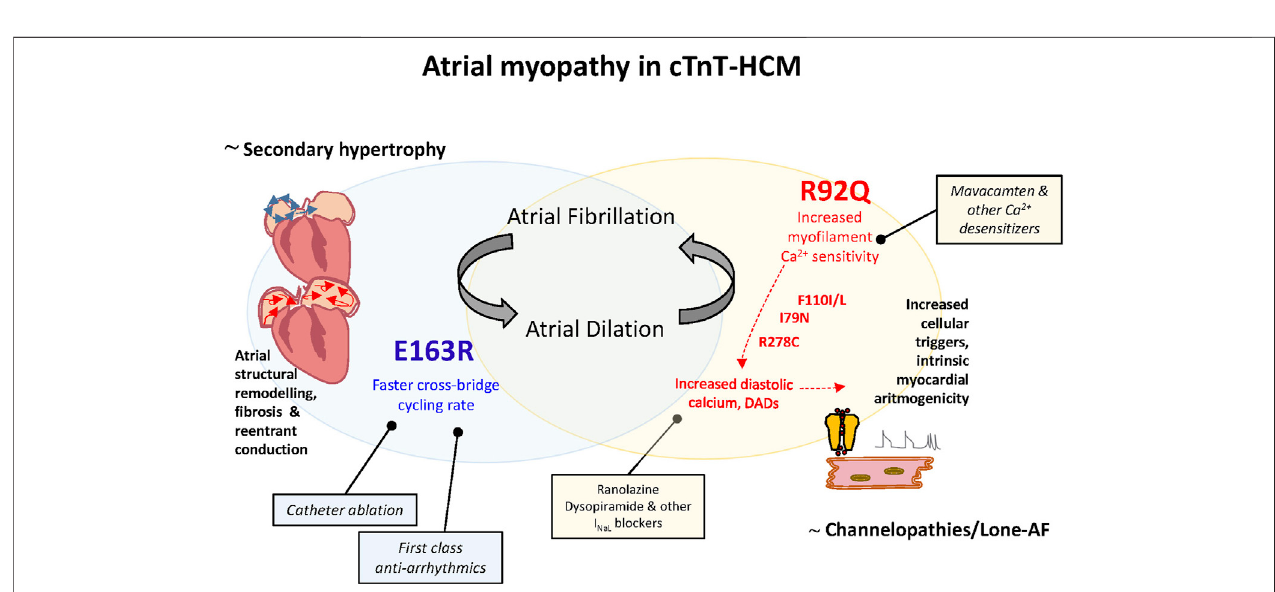
FIGURE 6 | Atrial myopathy in cTnT-HCM: different pathogenesis of atrial cardiomyopathy, different genotype-driven therapeutical strategies for AF. Left: Atrial myopathy in E163R cTnT-HCM is likely a consequence of increased LV fi lling pressures as in secondary hypertrophy and other chronic LV conditions. In this case, AF would be predominantly sustained by atrial tissue structural remodeling and associated micro and macro reentrant conduction and fi rst class antiarrhythmics to slow down conduction velocity and catheter ablation could be the recommended fi rst choice treatments. Right: Atrial myopathy in R92Q cTnT-HCM is likely a direct effect of the mutation as in other genetic-based forms of AF. We identi fi ed the increased atrial and ventricular myo fi lament calcium sensitivity associated to this mutation asthetriggerforcellulararrhythmiasdeterminedbycalciumhandlingdysregulation,aspreviouslydemonstratedforothercTnTmutations.Inthiscasedrugsthatdirectly decrease sarcomere calcium sensitivity or ameliorate cell calcium homeostasis can be more bene fi cial compared to classical antiarrhythmics and invasive treatments.